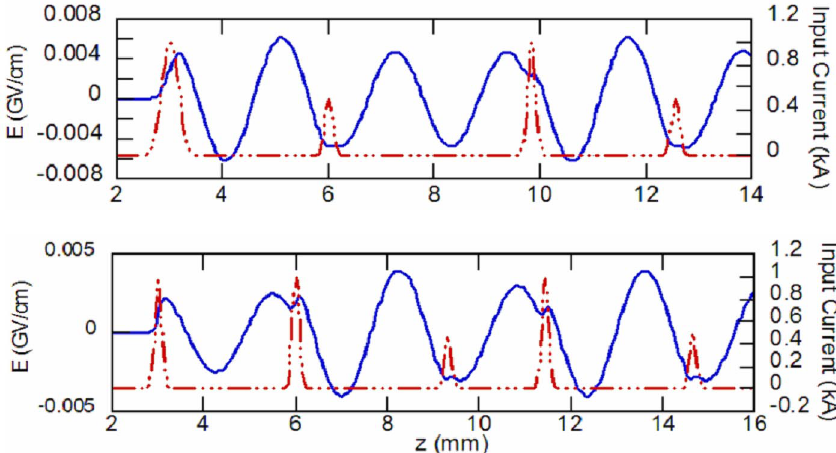
FIG. 4. (Color) Axial bunch current (dashed line) and longitudinal plasma wakefields for reduced bunch charge in alternate (load) bunches: (a) single initial drive bunch. Spacing between bunches is 3, 3.84, and 2.71 mm. Note that the pattern from z (cid:4) 6 to 12.5 mm repeats thereafter. (b) Two initial drive bunches. Spacing between bunches is 3, 3.3, 2.13, and 3.21 mm. Note that the pattern from z (cid:4) 7 to 12.5 mm repeats thereafter.